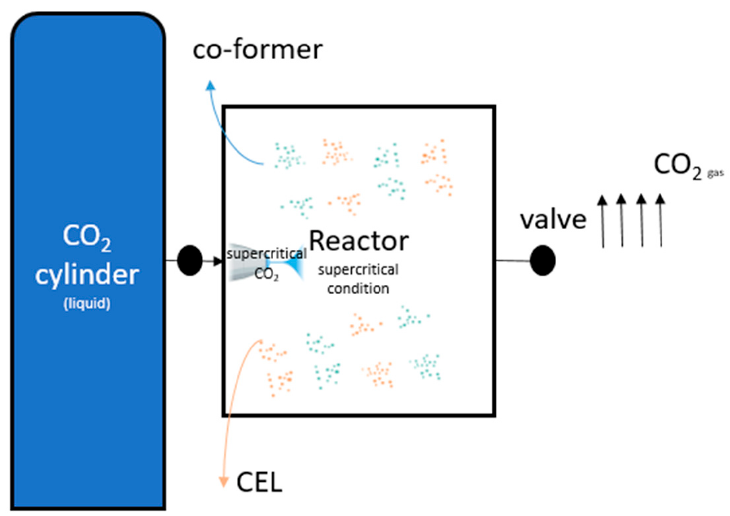
Figure 2. Schematic illustration of the SCF experimental apparatus.